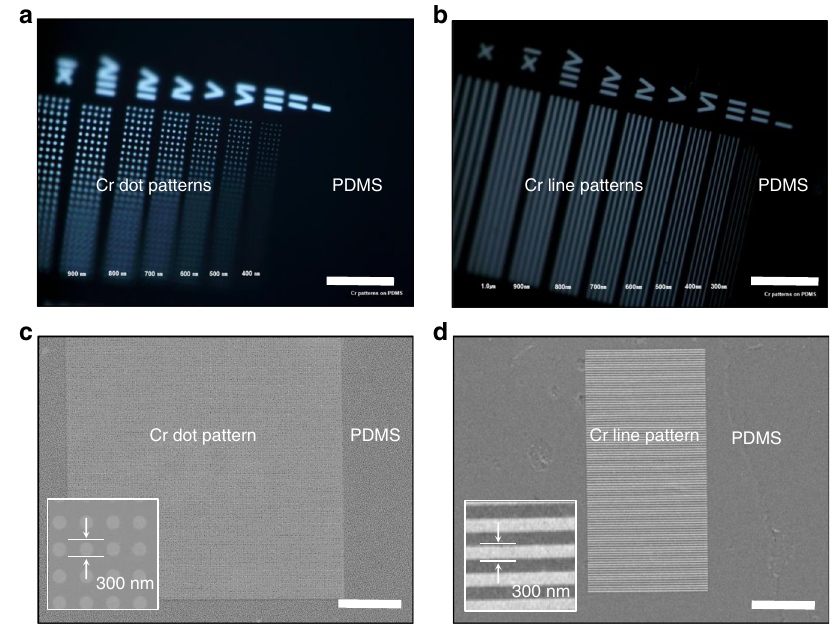
Fig. 2 Cr patterns in the soft photomask are highly accurate and crack-free. a , b Optical microscopy images of soft photomask containing Cr dot ( a ) and line ( b ) patterns. Scale bar: 20 μ m. c , d Scanning electron microscopy (SEM) images of Cr dot ( c ) and line ( d ) patterns. The insets show magni fi ed images. Scale bar: 10 μ